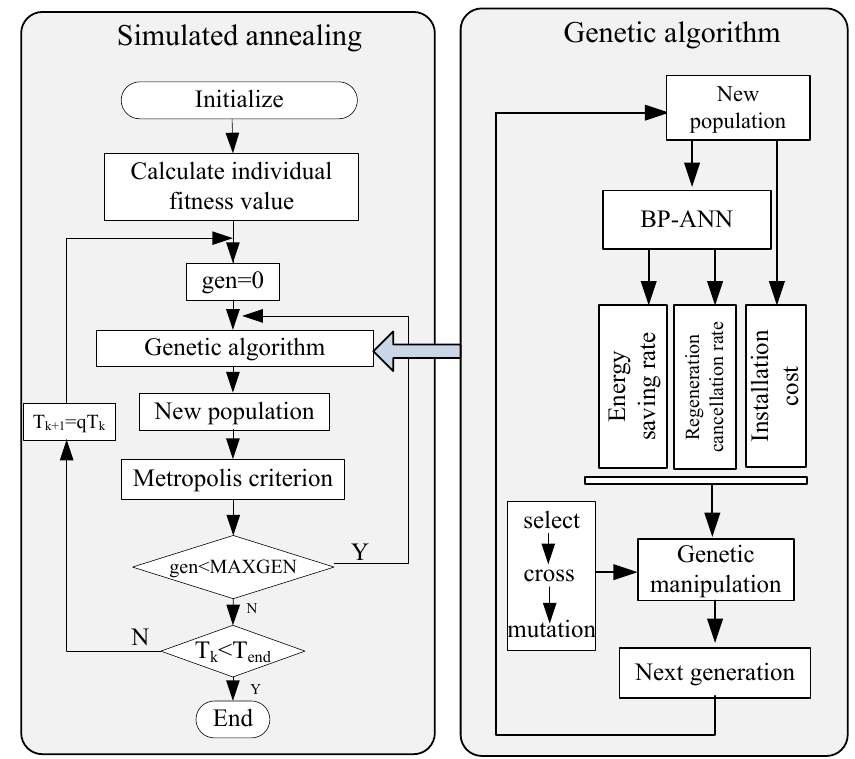
Figure 19. SAGA flow chart.